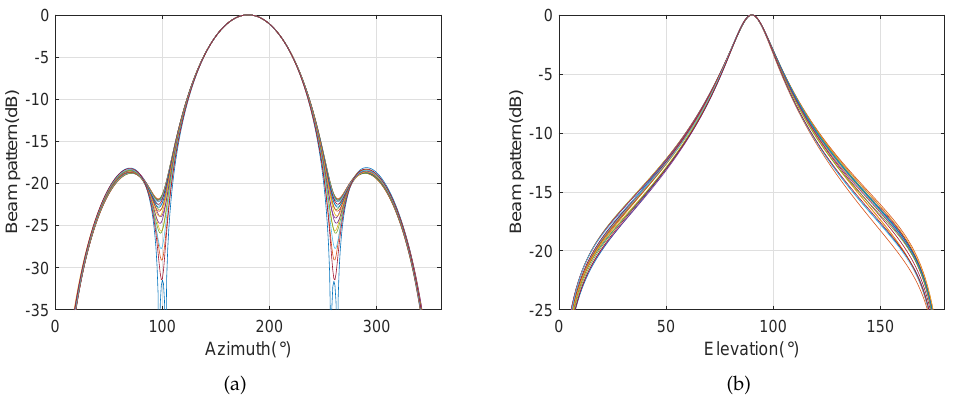
Figure 16. The beampatterns on the azimuth and elevation planes, where SNR is equal to 5dB. ( a ) Beampattern on the azimuth plane; ( b ) beampattern on the elevation